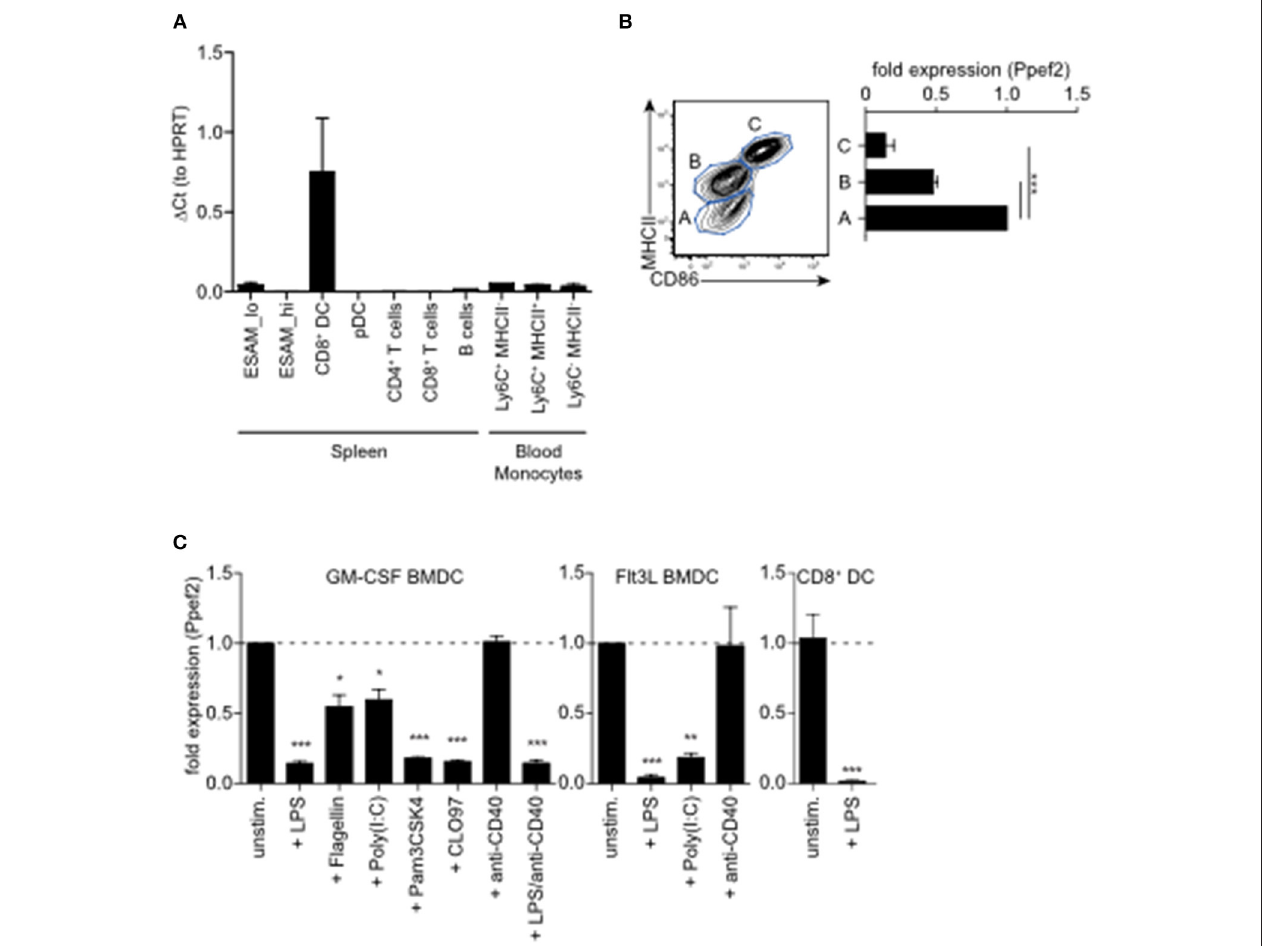
FIGURE 1 | Ppef2 is predominantly expressed by CD8 + cDC1. (A) Gene expression profiling of spleen and blood cells after sorting. Shown is the quantitative real-time PCR result for Ppef2 of three independent sort experiments ( n = 3 pooled mice per sort) ± SEM analyzed by the 1 Ct method with HPRT as housekeeping gene. Cells were identified and sorted as ESAM hi (CD11c + MHCII + CD11b + ESAM hi ); ESAM lo (CD11c + MHCII + CD11b + ESAM lo ); CD8 + DC (CD11c + MHCII + CD11b − CD8 + ); pDC (CD11b − SiglecH + ); CD4 + T cells (CD3 + CD4 + ); CD8 + T cells (CD3 + CD8 + ); B cells (CD19 + B220 + ); blood monocytes NK1.1 − B200 − CD115 + CD11b + Ly6G − cells with differential Ly6C and MHCII expression as indicated. Gating strategies are shown in Supplemental Figure 1B . (B) Ppef2 expression in GM-CSF cultured BMDCs of C57BL/6 mice after cell sorting on day 7 of culture based on the expression of CD11c, MHCII, and CD86. Error bars represent SEM of 3 independent experiments. (C) Ppef2 expression 16h after in vitro stimulation with the indicated TLR-ligands of GM-CSF- or Flt3L-cultured BMDCs of C57BL/6 mice, as well as spleen CD8 + DCs 16h after intravenous injection of 10 µ g LPS as determined by qPCR. Bar graphs with SEM represent pooled data from independently performed cell cultures [GM-CSF BMDCs: unstim., LPS ( n = 5); Flagellin, Poly(I:C), Pam3CSK4, CLO97, ( n = 4); anti-CD40, LPS + anti-CD40 ( n = 3); Flt3L BMDCs ( n = 3); sorted CD8 + DCs ( n = 4)]. Statistical analysis was performed using Student’s t -test, with * p < 0.05; ** p < 0.01; *** p <